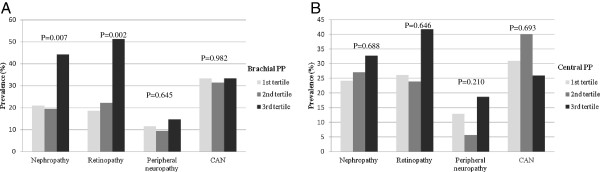
Prevalence of diabetic microangiopathies according to the tertile levels of the PP. (A) Brachial PP. (B) Central PP.